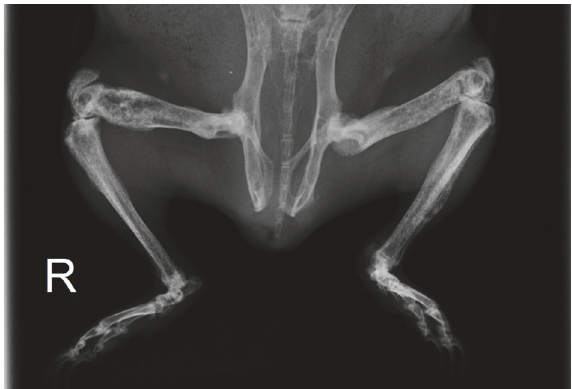
Figure 1: Ventrodorsal view of the rear third of a 20-month-old guinea pig with fibrous osteodystrophy. Deformation, a double cortical line, a marked trabecular pattern, and the absence of a normal medullary cavity of the long bones are observed.